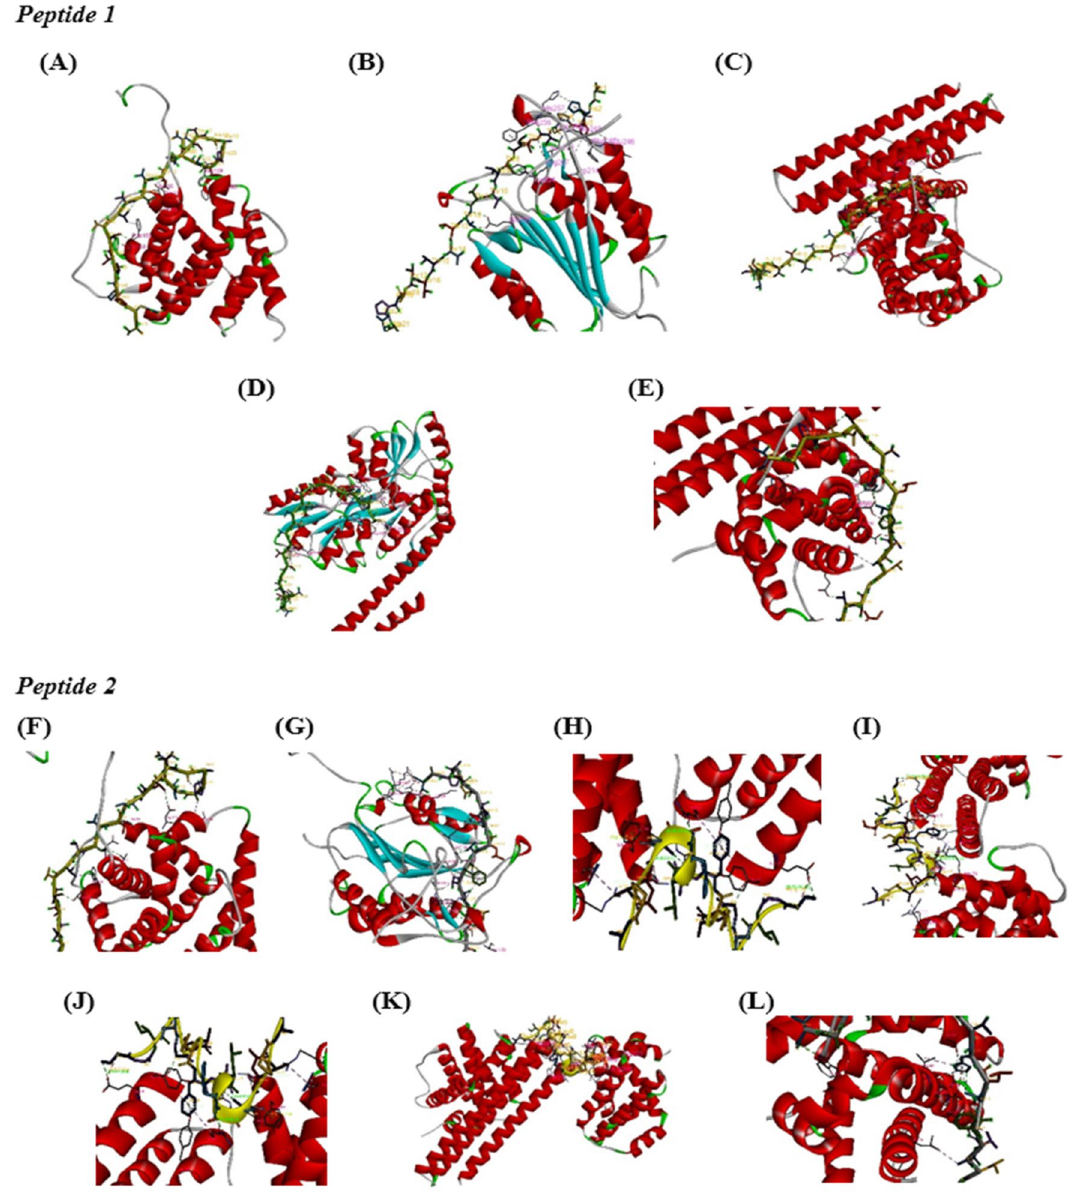
Figure 14. Peptide-protein docking 3D model by using HPEDOCK. ( A ) AtMP1-BAX docking model, ( B ) AtMP1-caspase-3 docking model, ( C ) AtMP1-caspase-9 docking model, ( D ) AtMP1-p53 docking model, ( E ) AtMP1-BCL2 docking model, ( F ) AtMP2-BAX docking model, ( G ) AtMP2-caspase-3 docking model, ( H ) AtMP2-caspase-7 docking model, ( I ) AtMP2-caspase-8 docking model, ( J ) AtMP2-caspase-9 docking model, ( K ) AtMP2-p53 docking model, ( L ) AtMP2-BCL2 docking model. The results showed the interaction site between the peptides and the selected cell proteins (Original image are shown in Supplementary Figs. S6, S7, S8, S9, S10, S11, S12, S13, S14, S15, S16,